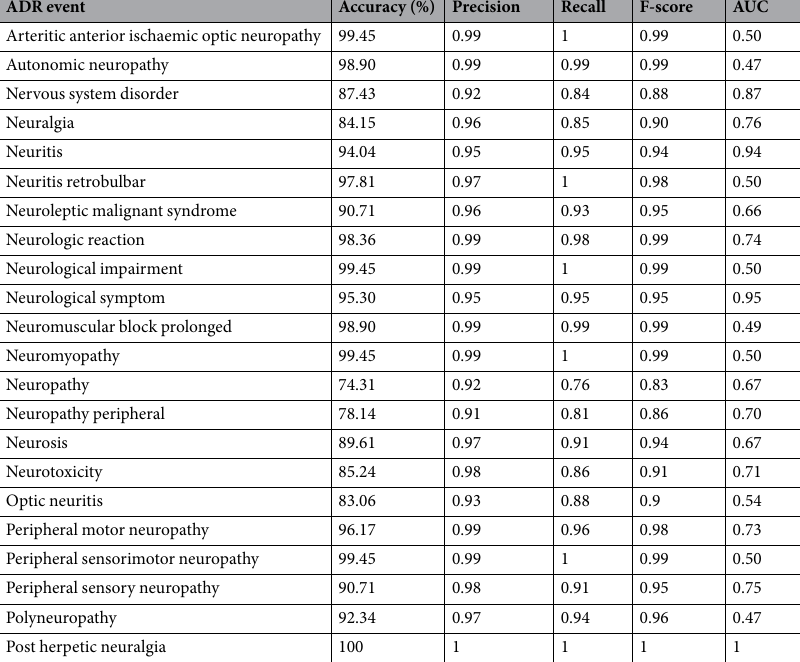
Table 5. Provides the performances of the models generated using the phenotypic features.